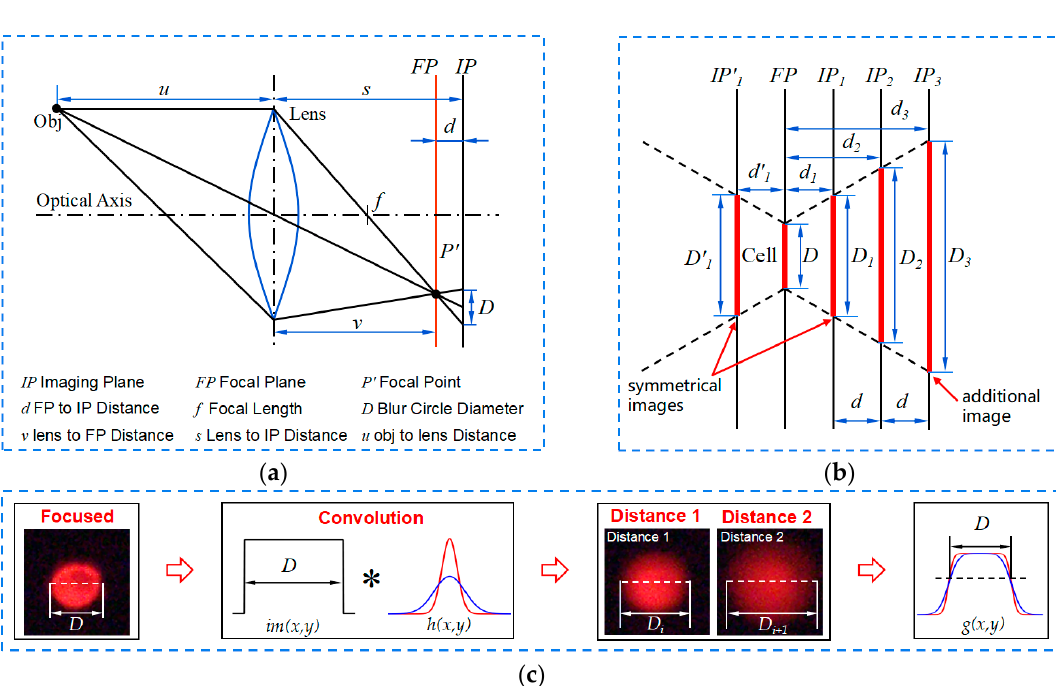
Figure 5. Theory of multiple depth from defocus (MDFD): ( a ) convex lens imaging model; ( b ) imaging model for cell; ( c ) theory of point spread function.